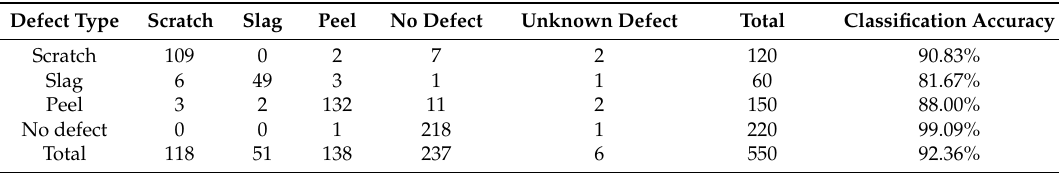
Figure 13. Classification accuracy changes with different threshold values. Table 8. Confusion matrix with unknown defect type. Table 8. Confusion matrix with unknown defect type.